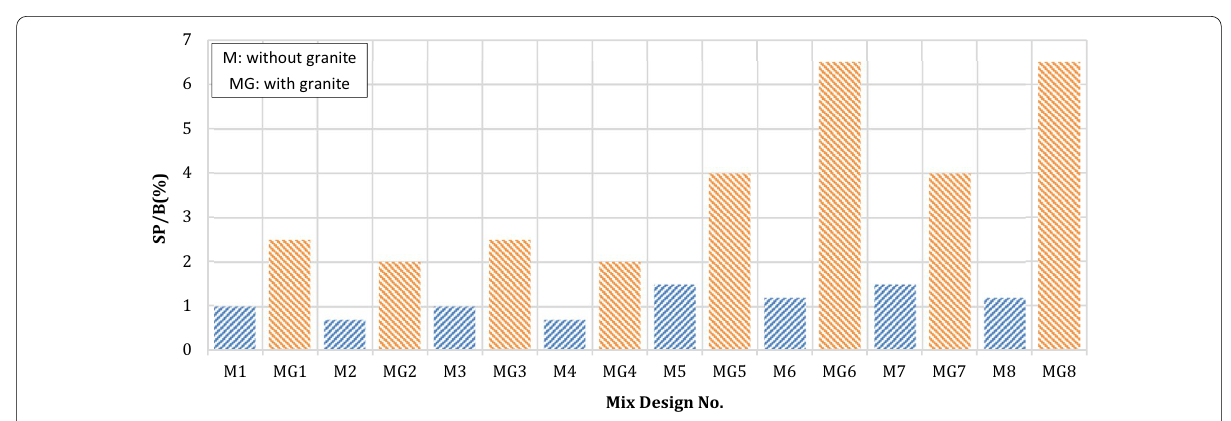
Fig. 19 Effect of GW on superplasticizer dosage of concrete